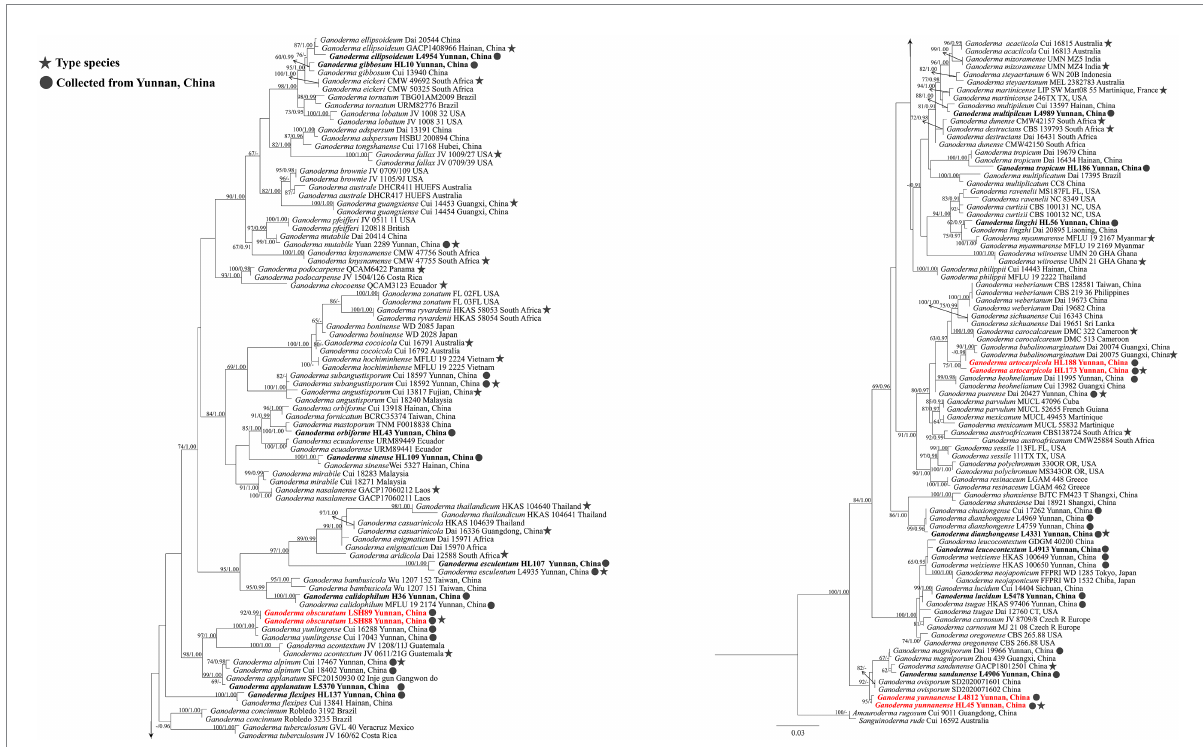
FIGURE 2 Maximum likelihood (ML) tree generated from a combined ITS + nrLSU sequence dataset. Bootstrap support values of maximum likelihood (ML) equal to or greater than 60% and Bayesian posterior probabilities (PP) equal to or greater than 0.90 are given above the nodes as “ML/PP.” New collections are indicated in black bold and new species are in red